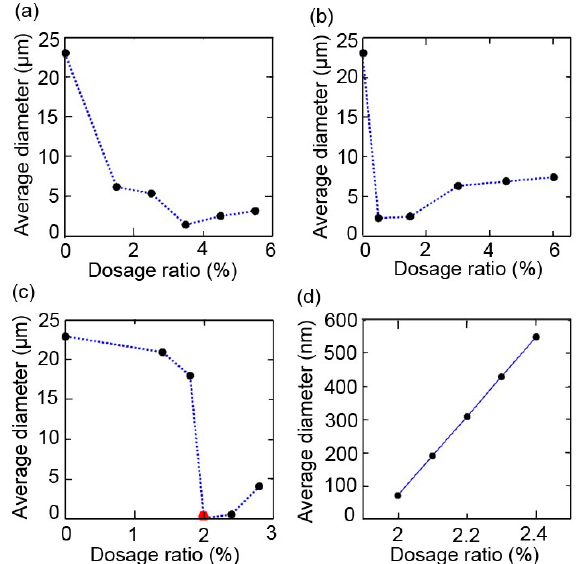
Figure 4. The average diameter of Nano-SiO 2 · 0.5H 2 O particles with ( a ) KH-550, ( b ) SDS, ( c ) KH-550, ( c , d ) SDBS as a modifier with other reagents held at the standard conditions. The red hexagon indicated the average diameter of nanoparticles synthesized at the standard conditions. The average diameter at this point is 70 nm.